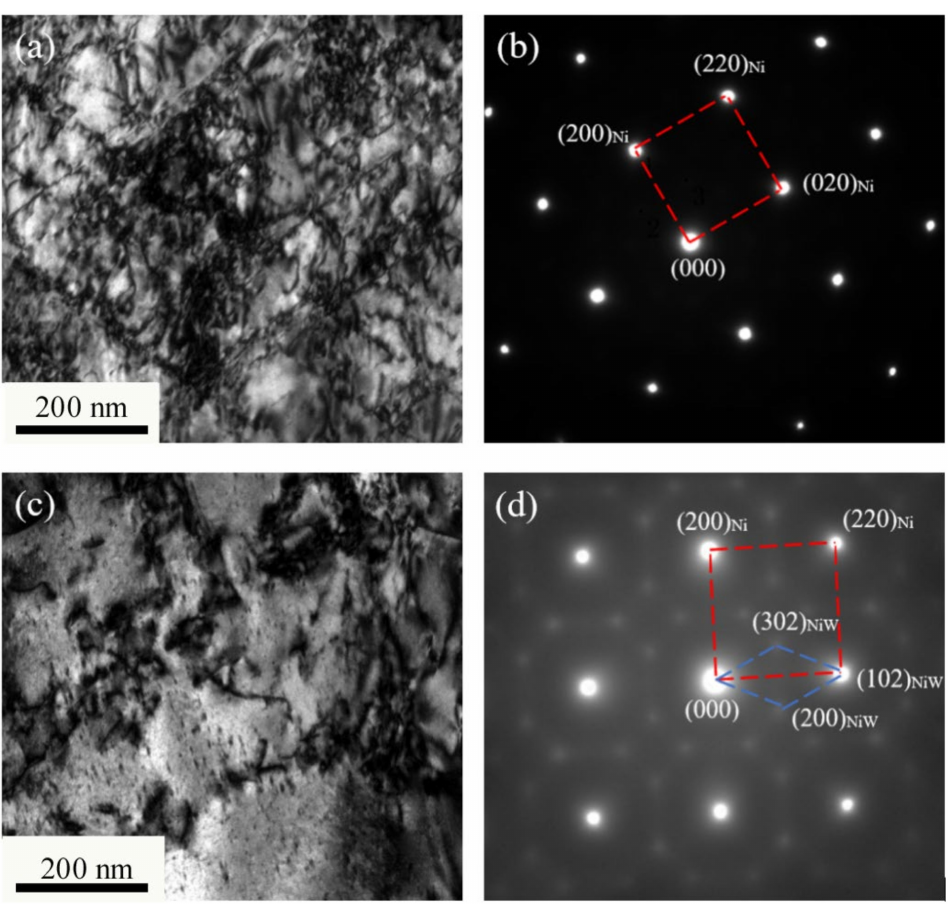
Figure 4. TEM micrographs and [001]Ni SAED patterns of the samples obtained by stretching at 400 ◦ C ( a , b ) and 600 ◦ C ( c , d